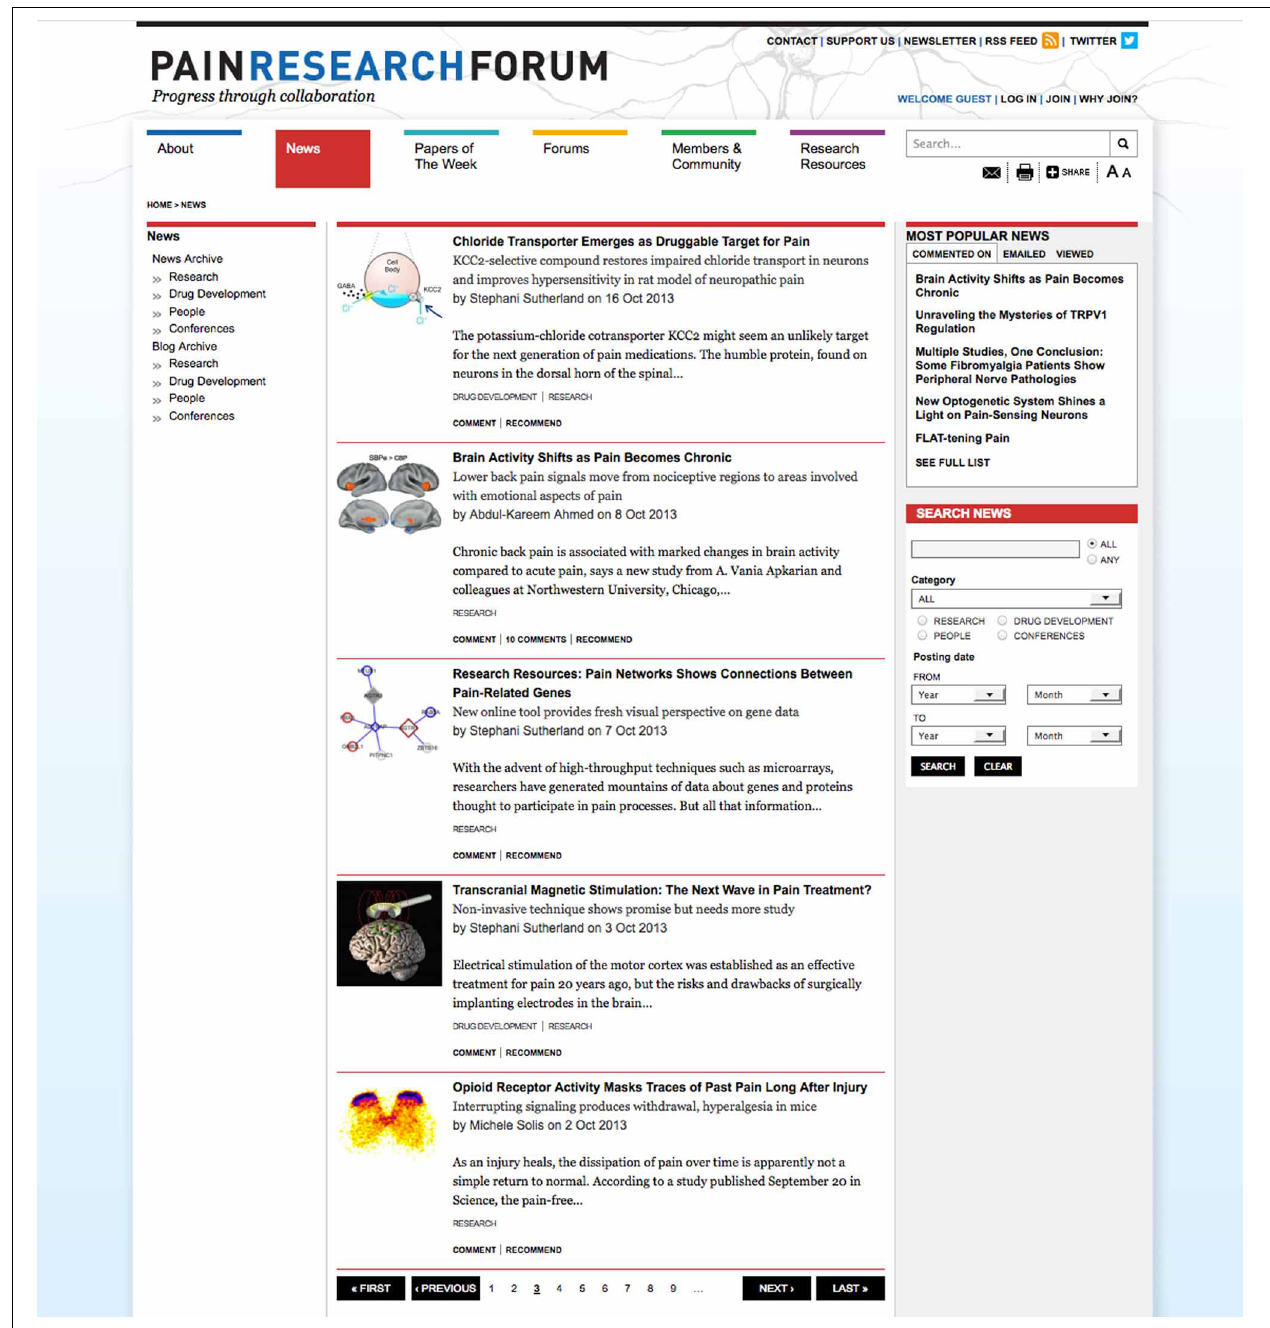
FIGURE 3 | News Section in PRF. Screenshot of news section in Pain Research Forum (http://www.painresearchforum.org/news). Five stories are listed per page, social media tools are available for each story. News stories can be filtered using categories on left. Most popular items are highlighted on the